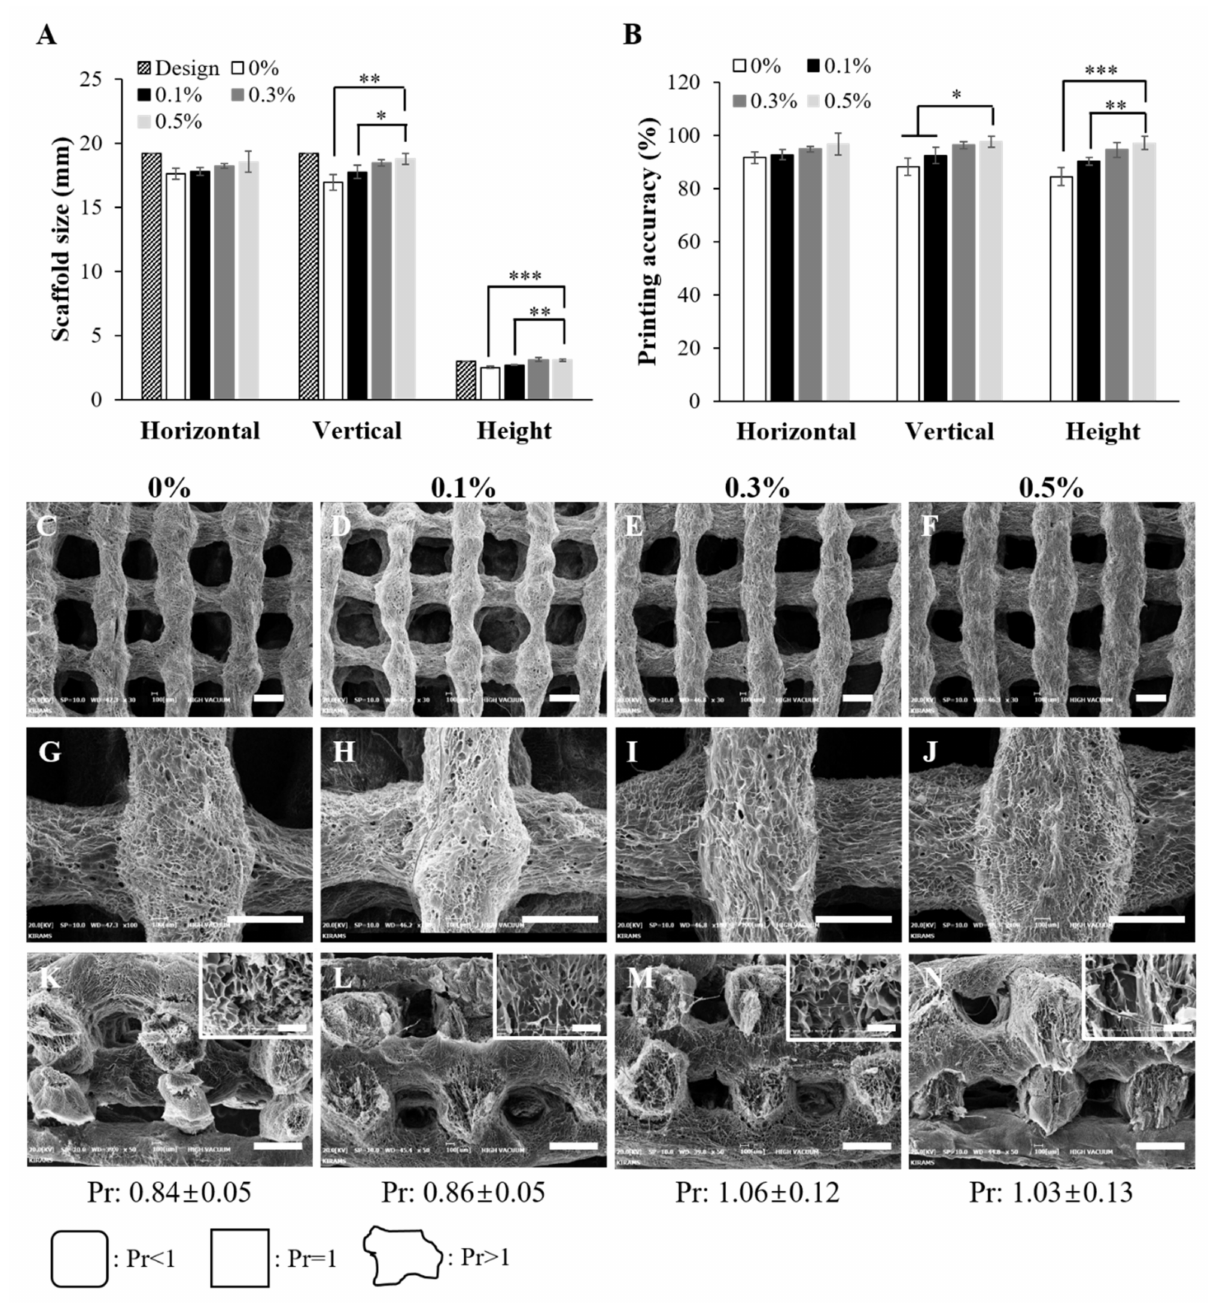
Figure 4. Printing accuracy, Pr value, and morphologies of the suture fiber reinforced gelatin 3D scaffold. ( A ) Plots of the sizes of the four different 3D printed scaffolds and of the CAD design. ( B ) Plots of the printing accuracies of the four different 3D printed scaffolds, with a 100% printing accuracy indicating no difference from the sizes of the CAD design ( n = 4) (* p < 0.05, ** p < 0.01, and *** p < 0.001). ( C – N ) SEM images of the ( C – J ) surfaces and ( K – N ) cross-sections of the 3D printed scaffolds reinforced with suture fibers at contents of ( C , G , K ) 0%, ( D , H , L ) 0.1%, ( E , I , M ) 0.3%, and ( F , J , N ) 0.5% (scale bar: 500 µ m; inset scale bar: 100 µ